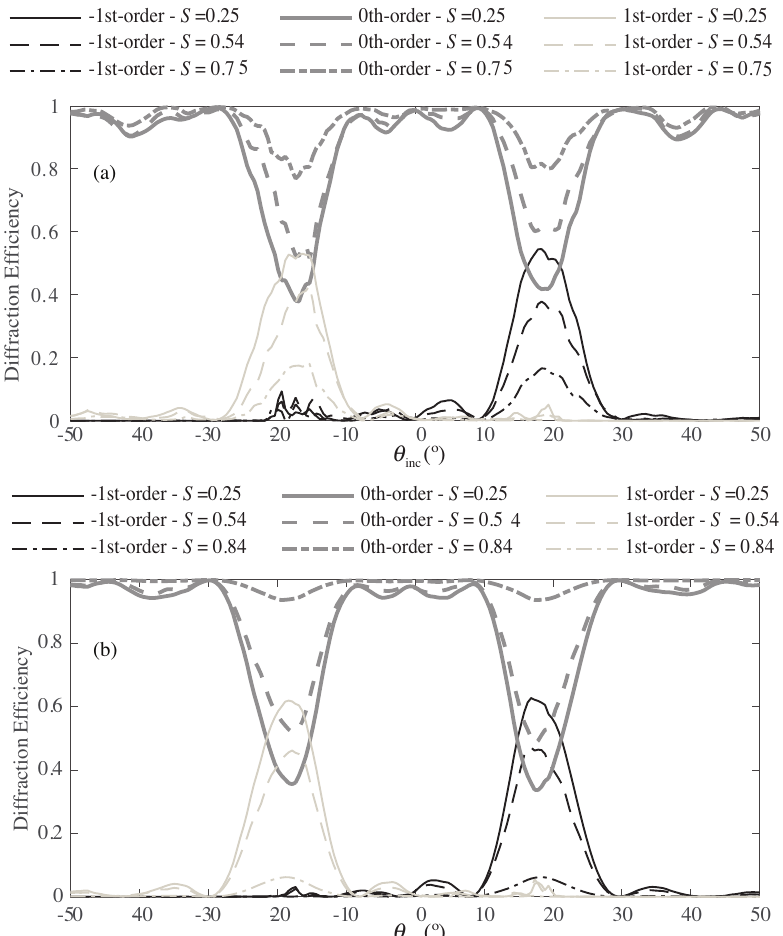
Figure 9. Diffraction efficiencies for the zeroth- and ± 1st-orders as a function of θ for different values of S for Grating #1: ( a ) Droplets sizes 75–150 nm; ( b ) droplet sizes 50–100